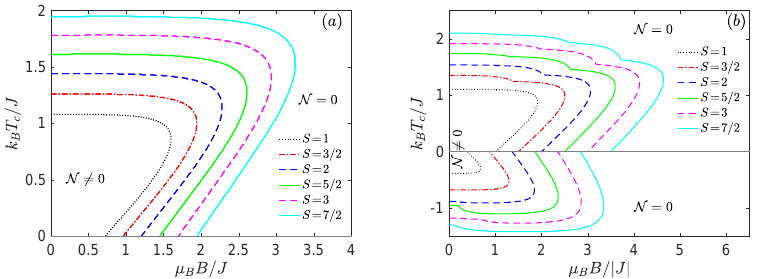
Figure 7. The behaviour of the threshold temperature as a function of external magnetic field and various spin- S magnitude. Results are calculated for two different values of uniaxial single-ion anisotropy: ( a ) D / J = − 0.2 and ( b ) D / J = 1,